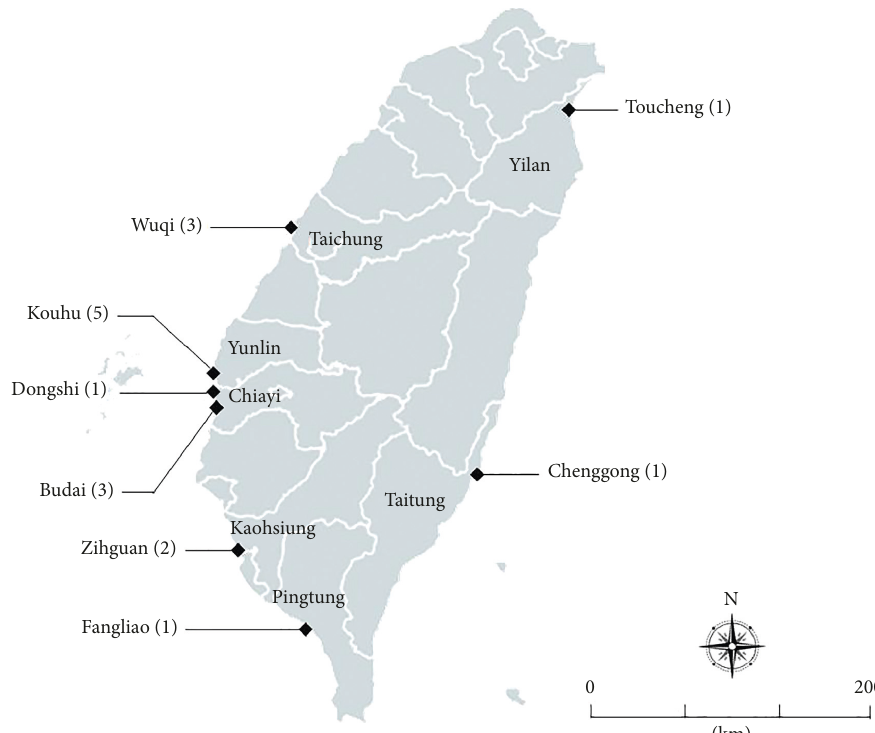
Figure 1: Map of sampling positions, Taiwan. Filled diamond points out the district/township name of shellfish cultivated locations. The number of obtained isolates also noted on this map, after each place name (in parenthesis). Table 2: Statistics of Shewanella haliotis isolated from aquaculture shellfish in Taiwan. Shellfish Number of samples Number of